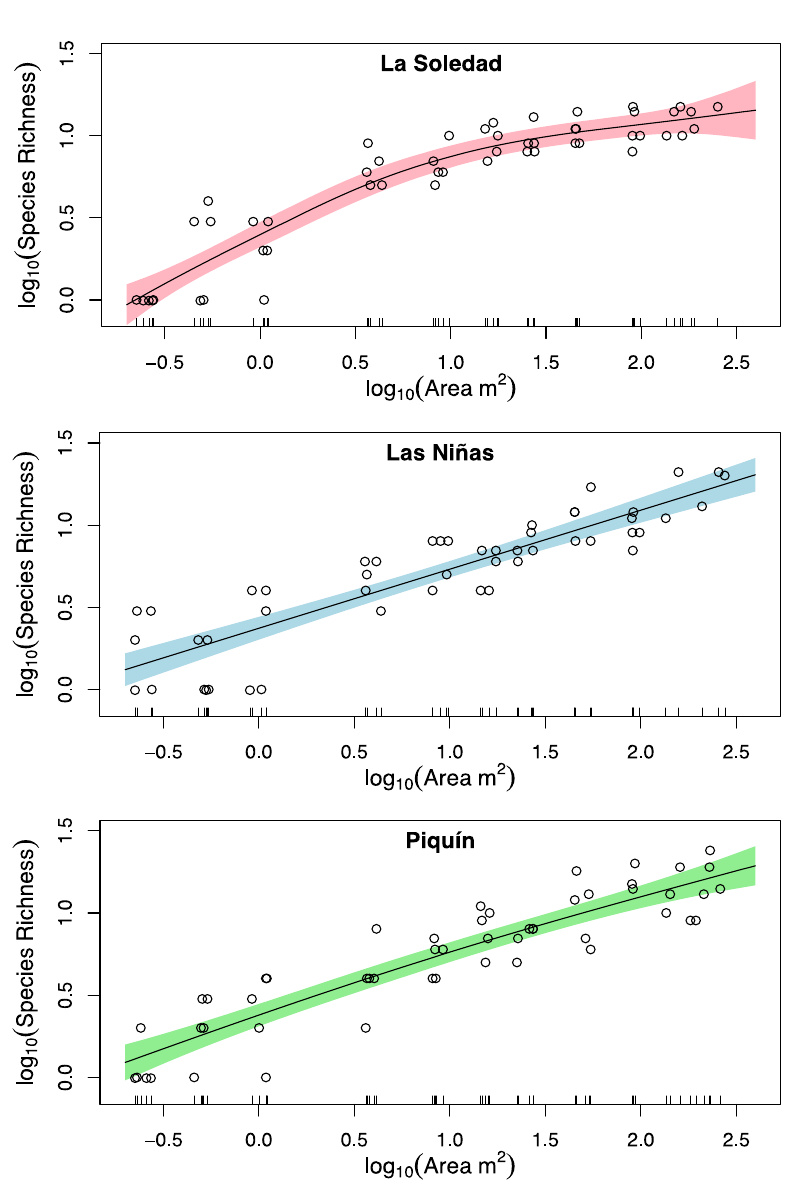
Figure 5. Assessing non-linear species-area relationships in the log-log space. The data is described by a generalised additive model allowing different intercepts and smoothing functions for each site (GAM, R 2 adj=0.829, AIC=-117.49; La Soledad: EDF=2.82, F=76.7, p<0.001; Las Niñas: EDF=1.00, F=221.81, p<0.001; Piquín: EDF=1.656, F=125.08